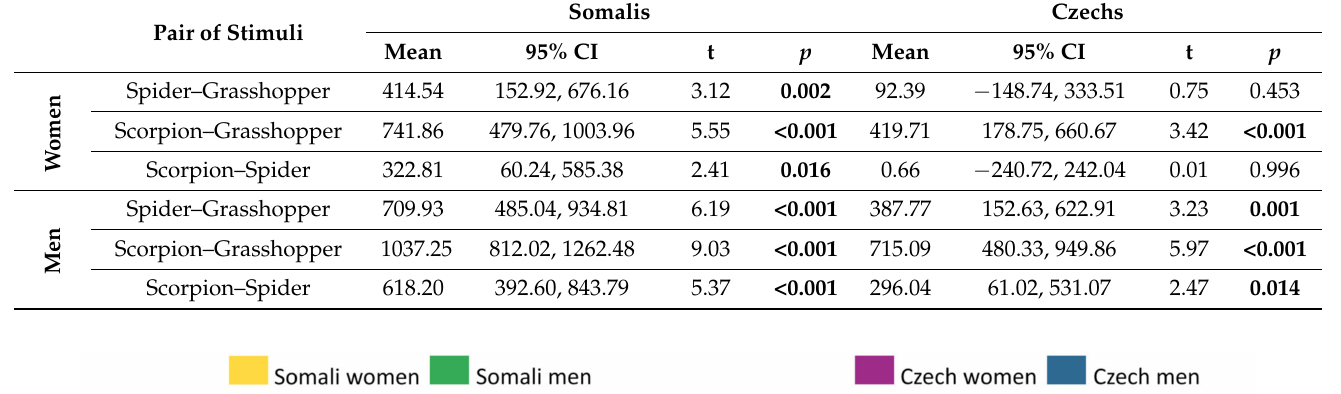
Table 2. Results of the linear mixed effect models for the difference between fixation time on the two stimuli − the estimated means for all levels of stimuli pair, nationality, and gender. All predicted estimates are tested against zero − positive values signify longer fixation time on the former animal in the pair and negative values on the later animal in the pair; p -values < 0.05 are in bold.